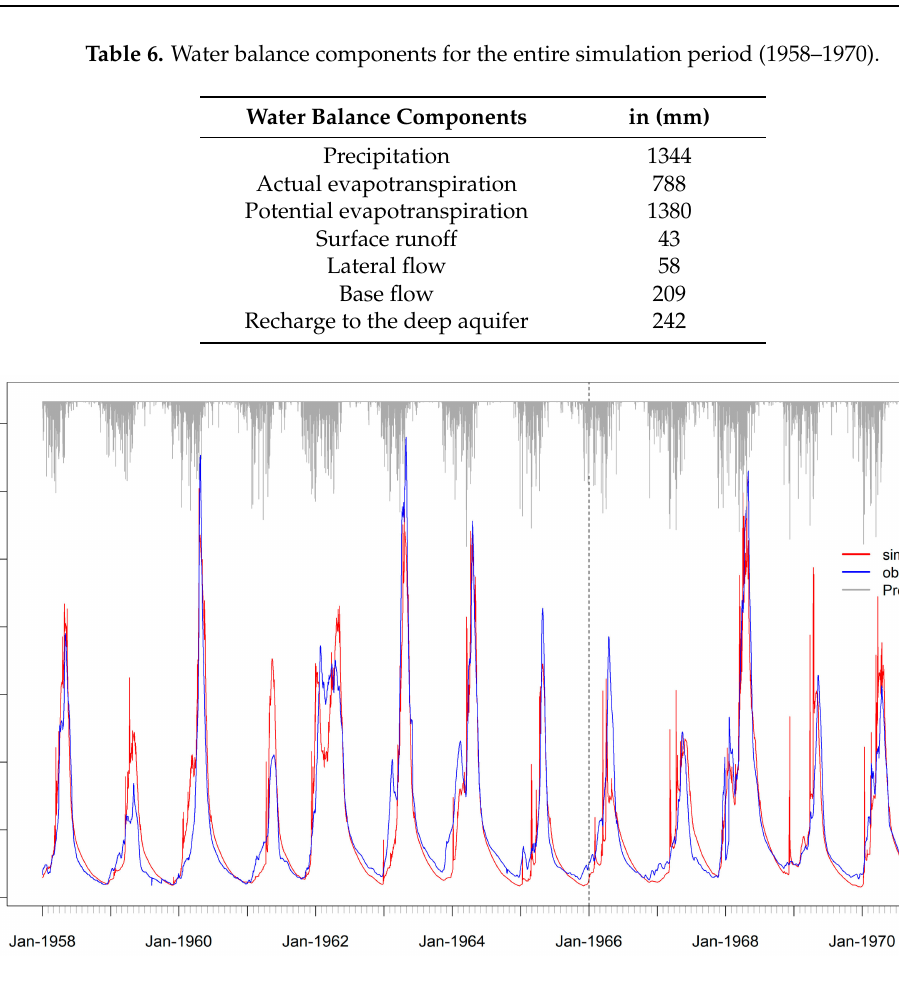
Figure 4. Hydrograph showing the observed and the simulated discharge for the calibration (1958–1965) and the validation period (1966–1970), separated by the vertical dashed line. Statistical measures are shown in Table